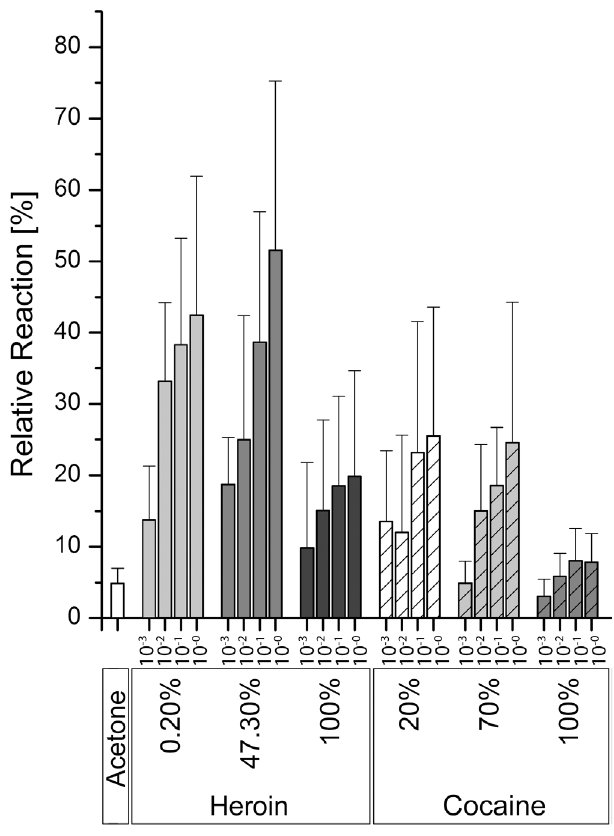
Fig 2. Honeybee antennal responses to four dilutions of the test samples in acetone, relative to the response to a cis -3-hexenol standard (concentration 1 ng/ μ l in acetone). Error bars indicate standard deviations (n =